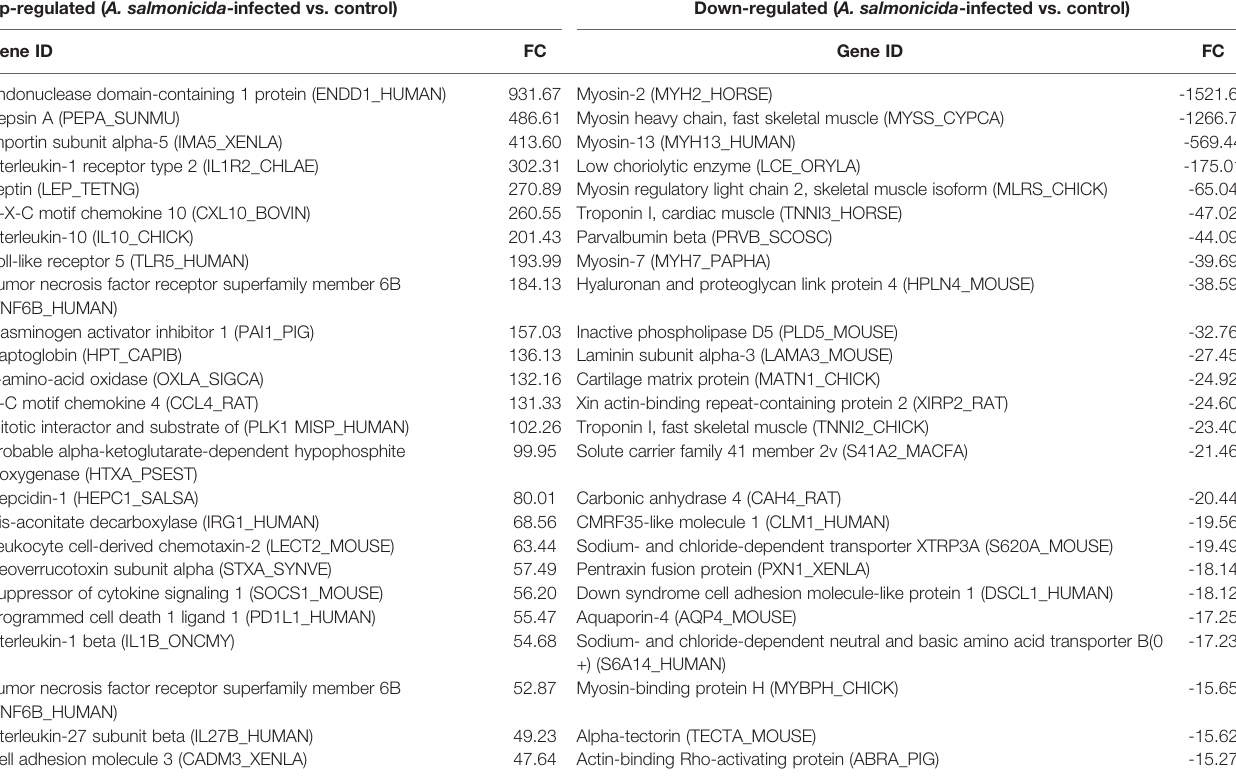
TABLE 1 | Top 25 up- and down-regulated DEGs in the head kidney at 24 hpi. Up-regulated ( A. salmonicida -infected vs. control) Down-regulated ( A. salmonicida -infected vs.